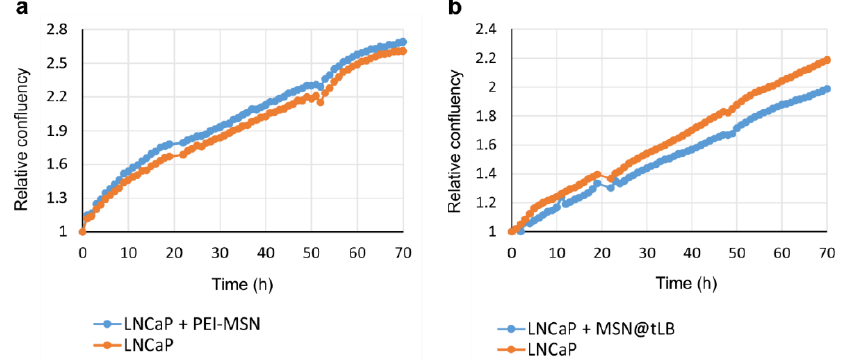
Figure 8. Confluency measurements over time for cells with and without MSNs. The confluence of LNCaP cells unlabeled, labeled with PEI-MSNs ( a ) or labeled with MSN@tLB ( b ), was measured using live cell imaging device Incucyte ZOOM. For comparison between the different conditions, the initial confluency values were normalized to 1, and relative values were presented over time (hours).